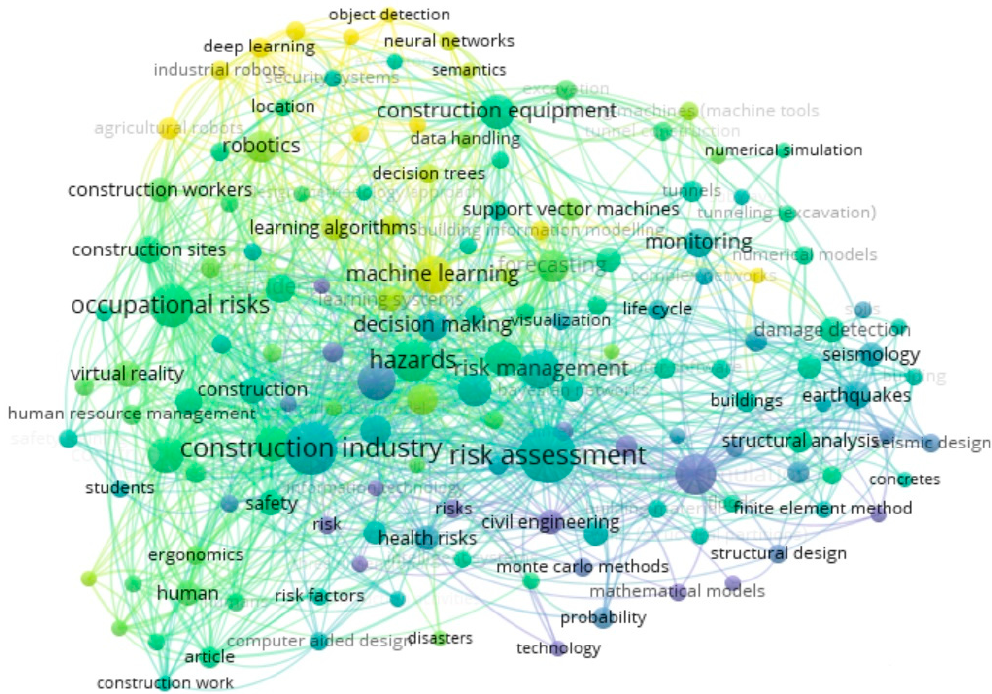
Figure 6. Keyword cooccurrence networks.